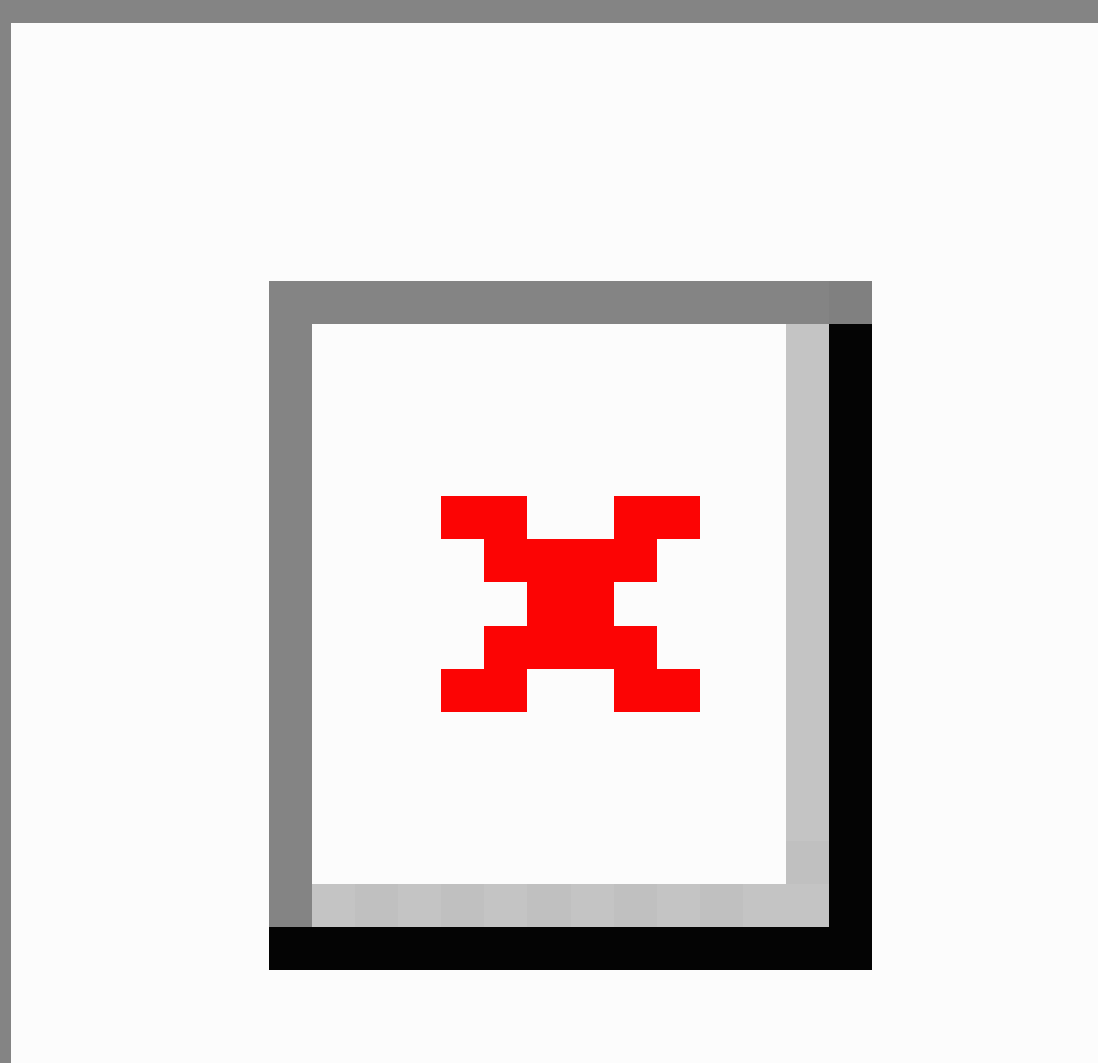
Figure 2. Peer-referral “Lifecycle” of a single hypothetical smoker through Share2Quit Intervention: 1: Seeds or peer navigator consents to be in the study and refers smokers from his network using S2Q tools. The system contacts the referred smokers and prompts them to register. 2: The referred smokers register on the system and consents to become a peer navigator (Wave 1 recruit). 3: The Wave 1 recruit then refers smokers from their social network and similarly the system prompts these smokers to register. 4: The referred smokers then registers on the system (Wave 2 recruit). 5: The chains progress until the target sample size is